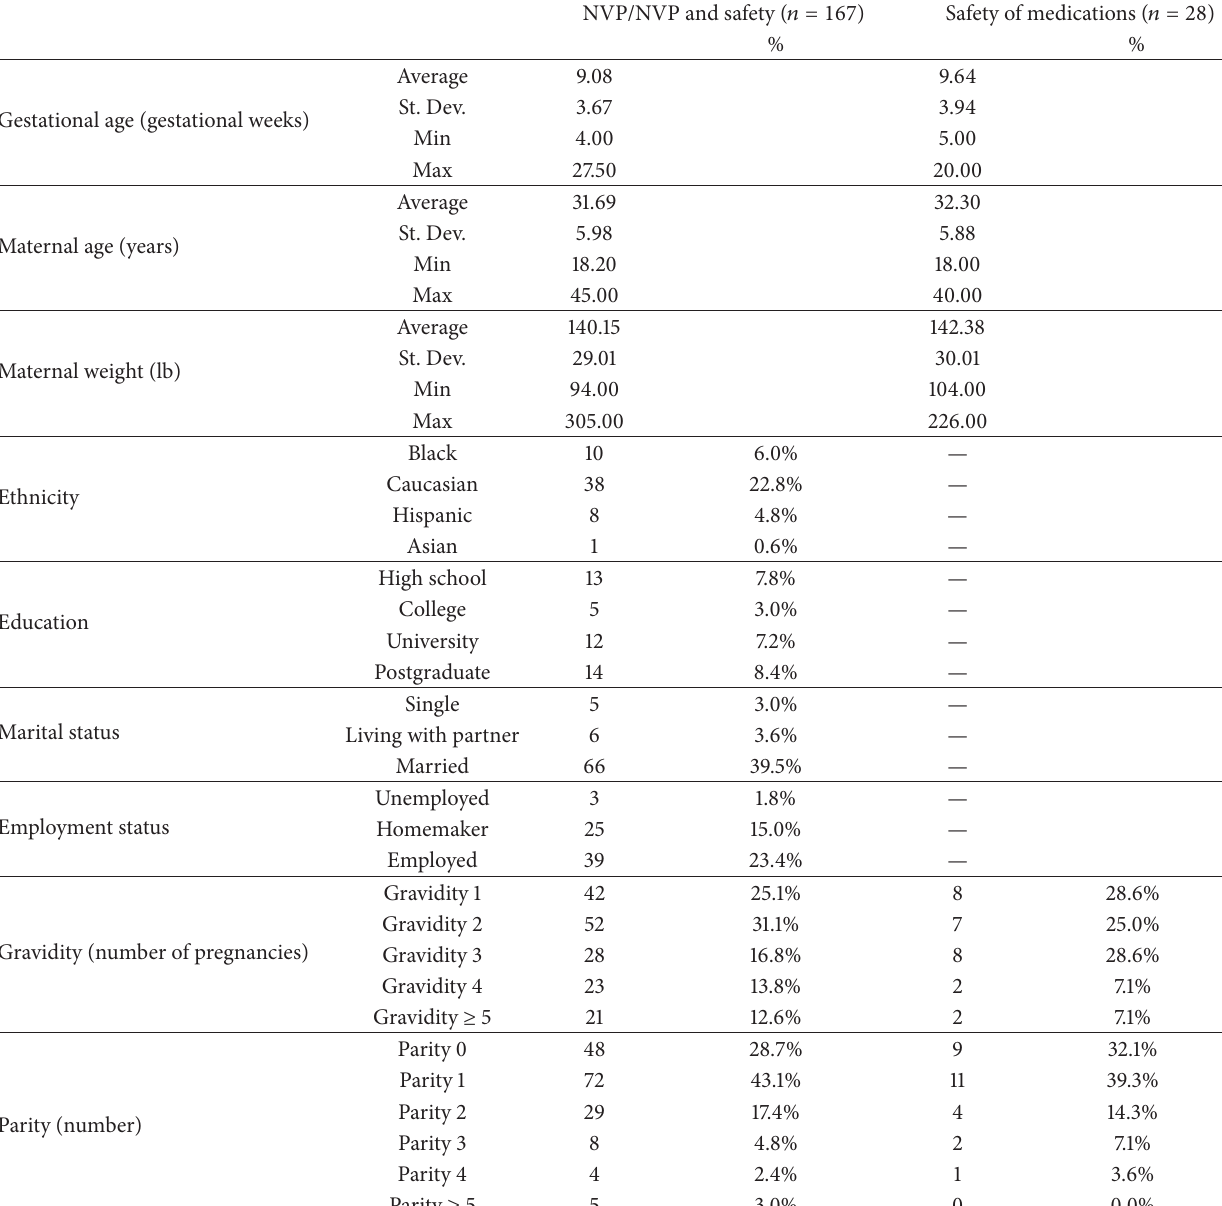
Table 2: Demographic characteristics of the 195 USA callers.